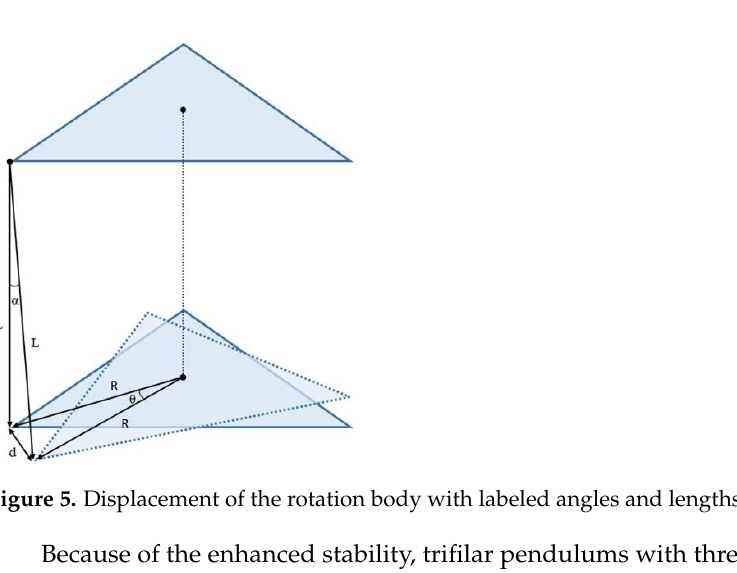
6 of 22 Figure 4. Trifilar pendulum. Adding wires to the basic torsional pendulum improves the setup ’ s stability, and the